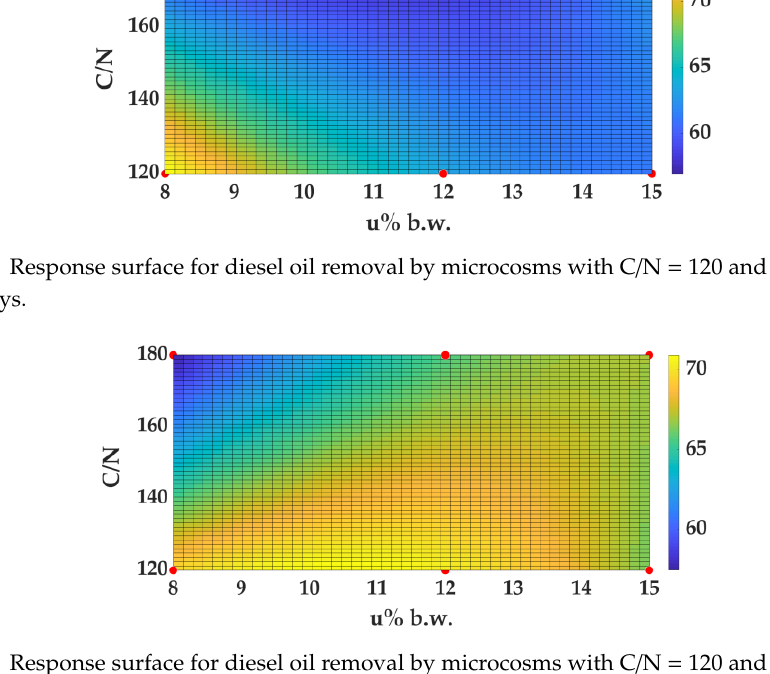
Figure 16. Response surface for diesel oil removal by microcosms with C / N = 120 and C / N = 180 at t = 138 days.